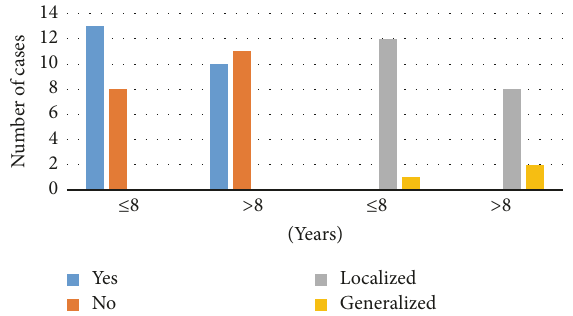
Figure 1: Number of cases and type of gingivitis.